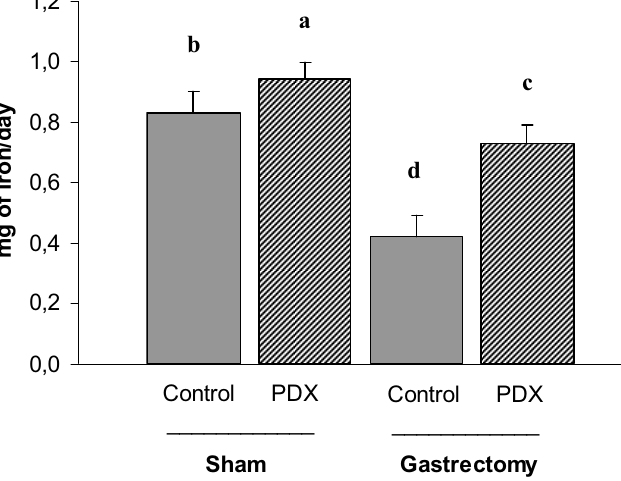
FIGURE 5 - Apparent iron absorption in sham operated or rats with gastrectomy fed diets with polydextrose (PDX) or without polydextrose (control). Each values represents the means ± SEM (Sham/Control: n=10; Sham/PDX: n=10; Gastrectomy/Control: n=9; Gastrectomy/PDX: n=9). Two ANOVA main effects (treatment and diet) and interactions (treatment x diet) were significant. Diet (control or PDX) treatment (with or without gastrectomy). Bars not sharing a common superscript are significantly different, p<0.05 (Duncan‘s multiple range